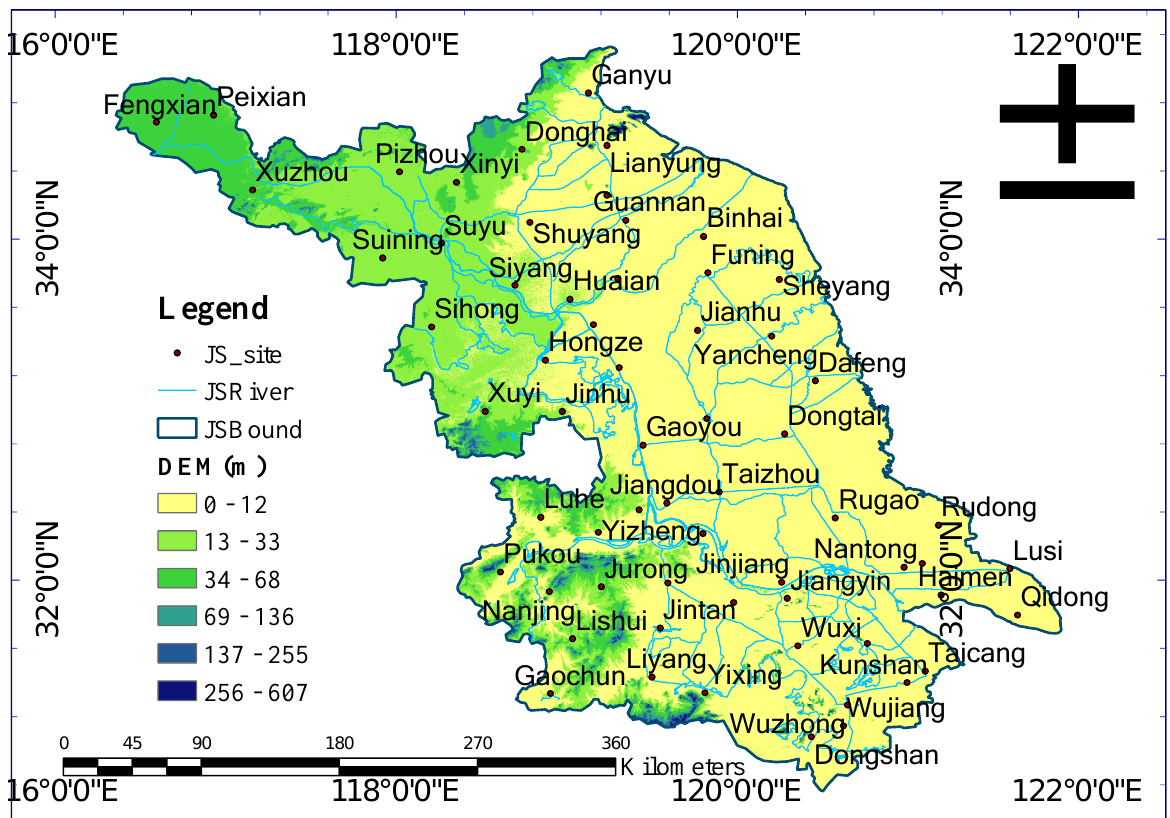
Figure 1. Map showing the locations of meteorological stations in Jiangsu province.